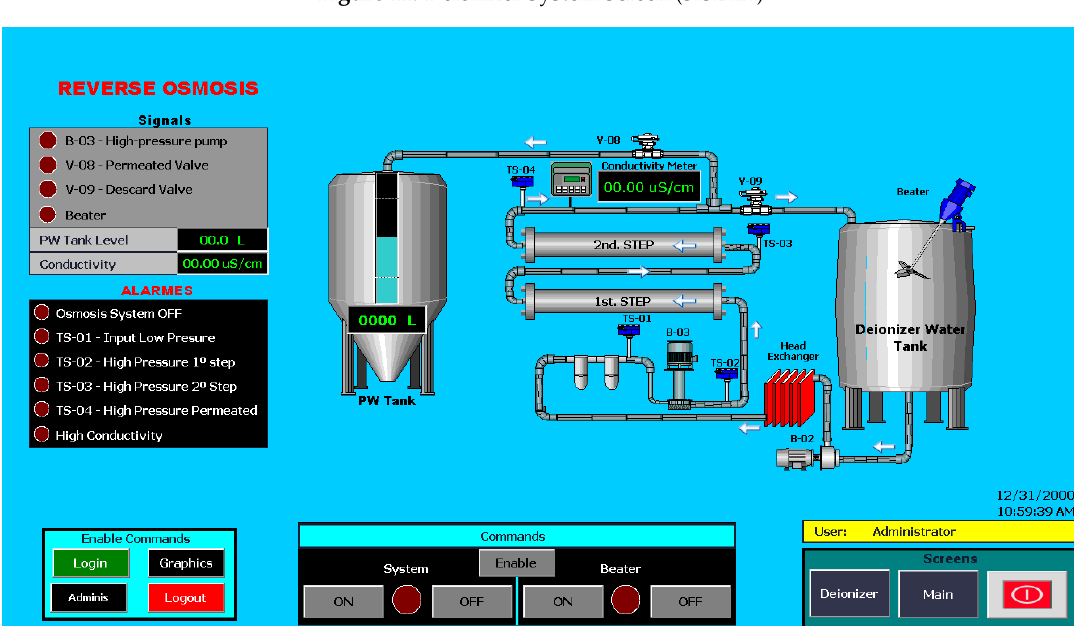
Figure 11. Deionizer System Screen (SISETA).